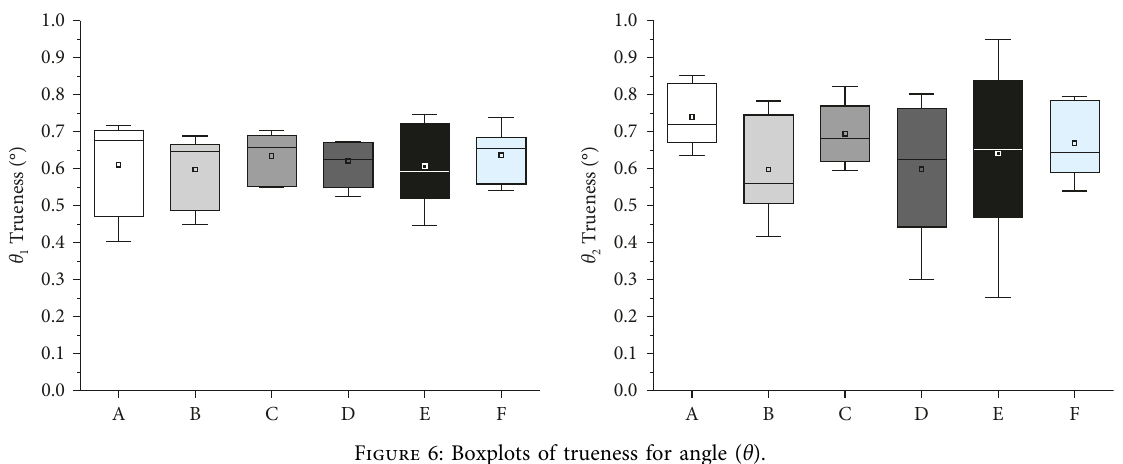
Figure 5: Boxplots of trueness for height ( h ).